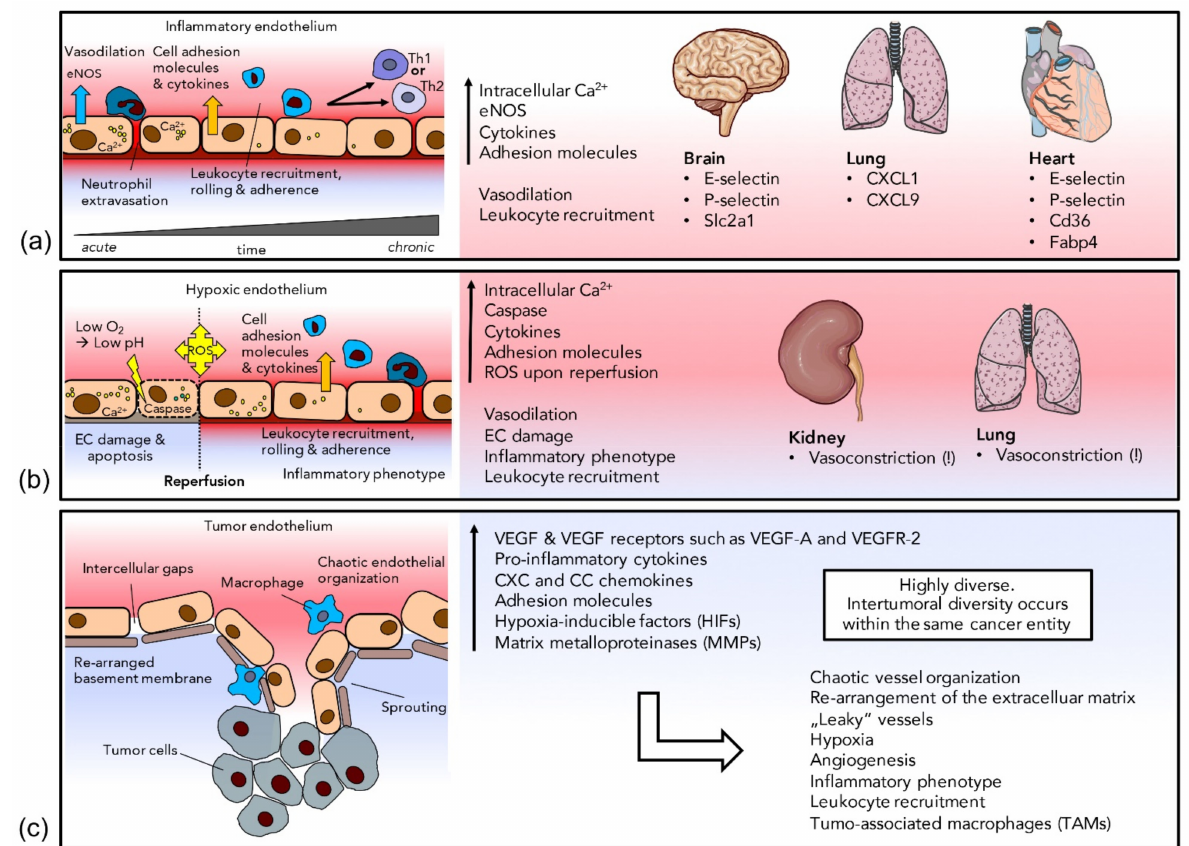
Figure 2. EC heterogeneity in response to stress. ( a ) During the acute inflammatory response, increased intracellular calcium activates eNOS and leads to vasodilation. Attracted neutrophils transmigrate through the endothelial layer. Upregulation of adhesion molecules and pro-inflammatory cytokines leads to further leukocyte recruitment. The attraction of either Th1 or Th2 cells determines the further inflammatory process. During inflammation, some organs, such as brain, lung and heart preferentially express certain adhesion molecules, cytokines or transporters. ( b ) The response to hypoxia shows some similarities to the inflammatory response. Intracellular calcium increases and, in most organs, leads to vasodilation. The small vessels of the kidney and the lung conversely react with vasoconstriction. Low oxygen and low pH lead to